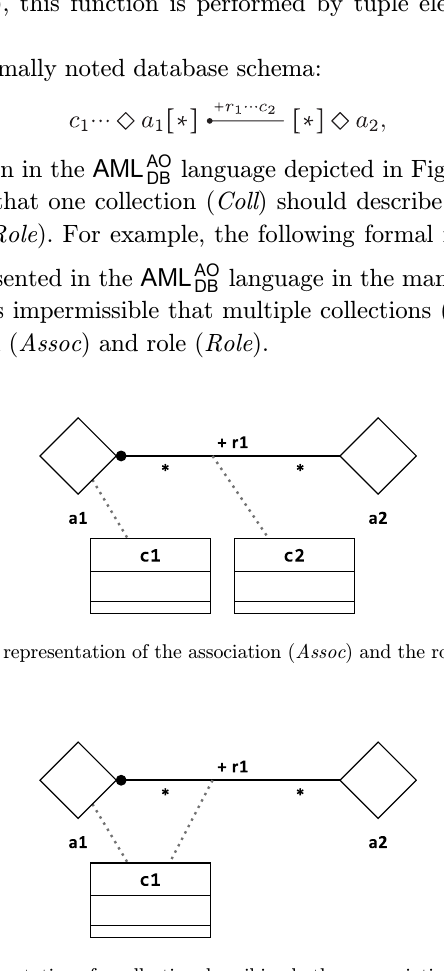
Fig. 14. Graphical representation of a collection describing both an association ( Assoc ) and a role ( Role ).